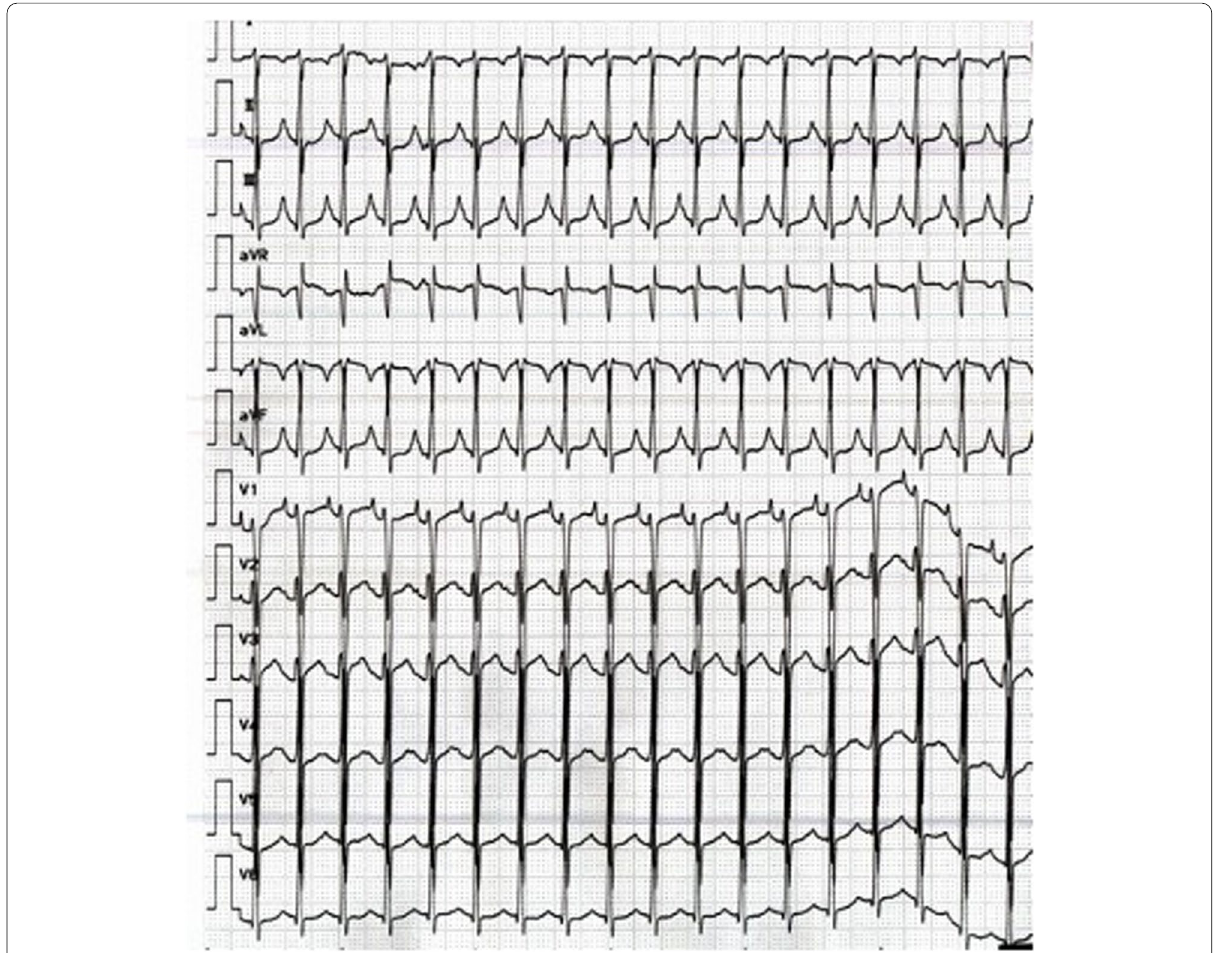
Fig. 1 Electrocardiogram on admission to ICU. Regular positive P waves of 180–190 bpm and corresponding narrow QRS waves are seen in V1 and V2, although the P wave is masked by the T wave in most